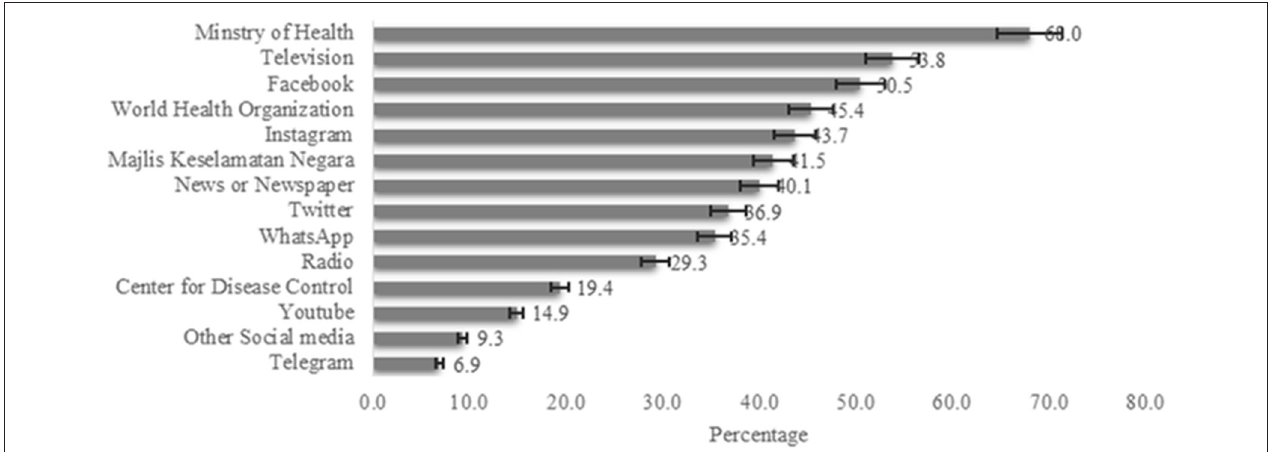
FIGURE 2 | Sources of Information of COVID19 among adult population in Malaysia ( n =